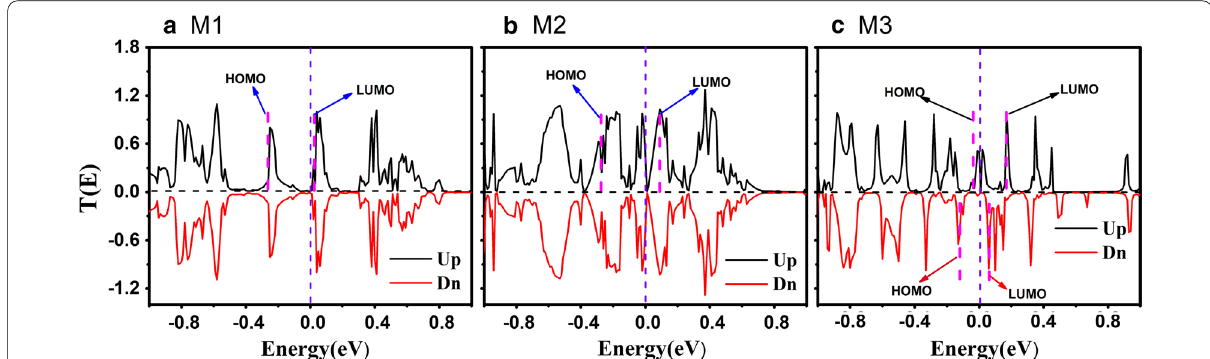
Fig. 3 (Color online) The spin-dependent transmission spectra at zero bias have exhibited for a M1, b M2 and c M3, respectively. The spin-up and -down transmission coefficients have been set as the positive (black) and negative (red) values. Meanwhile, the distributions of molecular projected self-consistent Hamiltonian have been denoted